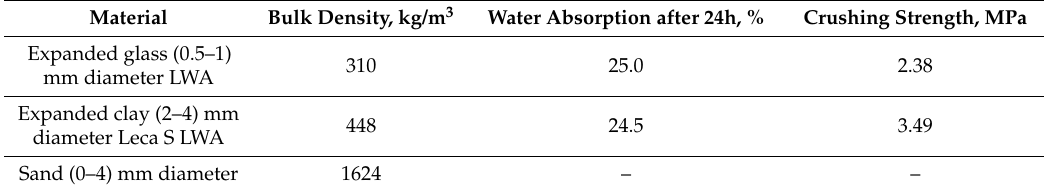
Figure 1. Granulometric curves of ( a ) aggregates; ( b ) microfillers and cement. Table 1. Properties of aggregates.